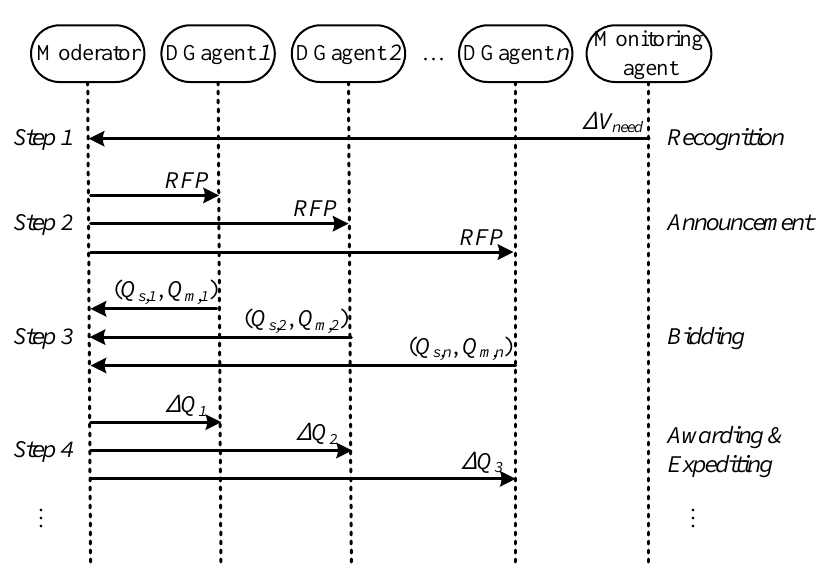
Figure 2. A summary of the voltage control